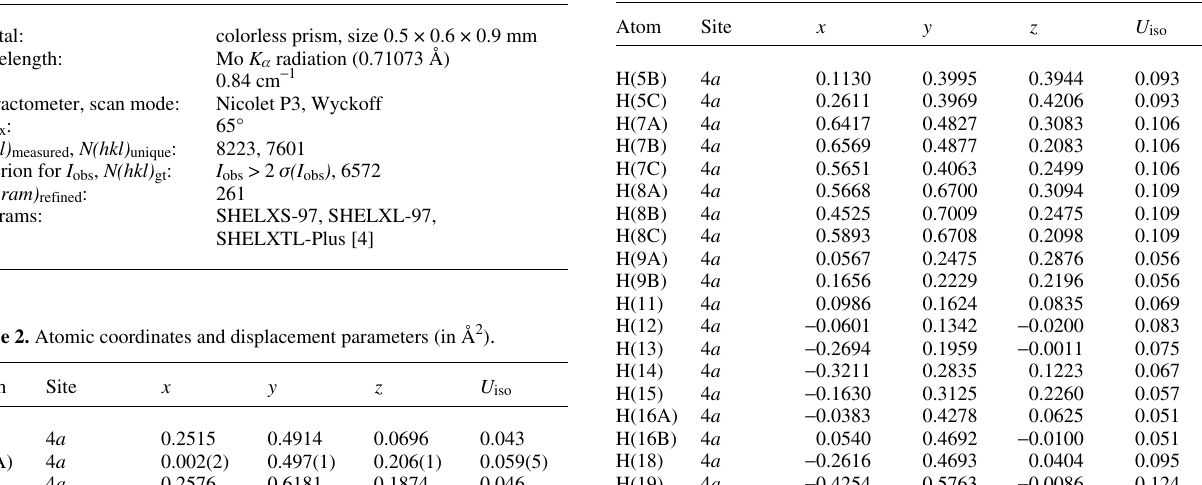
Table 1. Data collection and